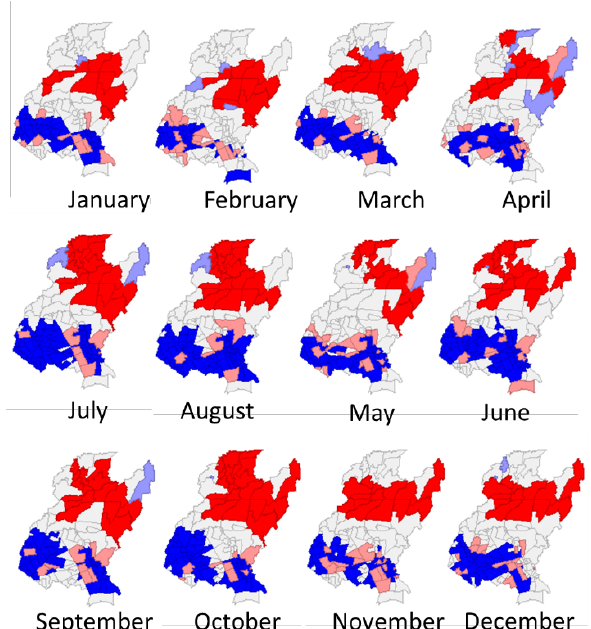
Figure 6. Spatial clusters based on LISA Moran’s I of monthly total cases in 2015